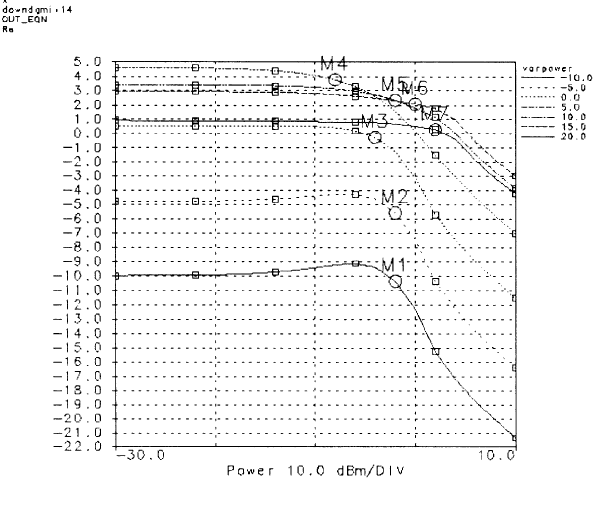
FIGURE 12 Conversion gain vs. the RF power while the LO power